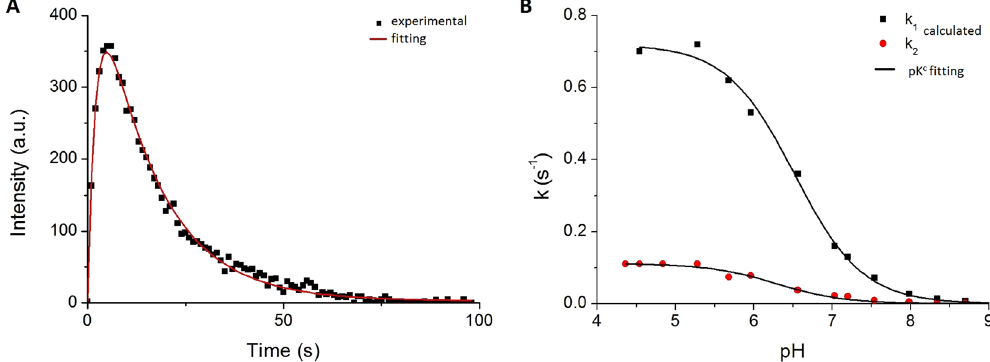
Figure 9. Analysis of SAASoti photoconversions. ( A ) Kinetic of SAASoti V127T photoconversion at 395 nm excitation and 580 nm emission at fixed pH. ( B ) pH profile of the rate constant of green-red photoconversion ( k 1 ), and rate constant for red form photobleaching ( k 2 ). Points are the experimental data, lines are